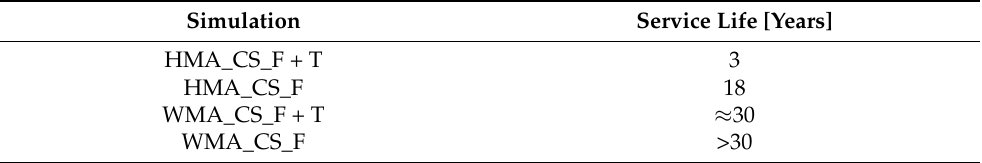
Table 5. Outcomes of the FlexPAVE simulations in the case of cracked